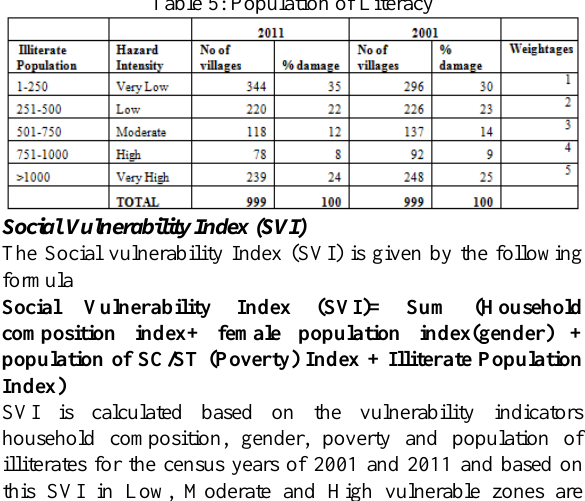
Table 5: Population of